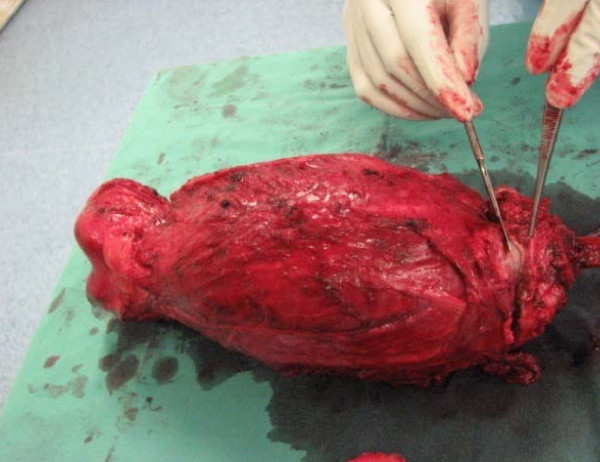
Soft tissue and periosteum is stripped off the primary tumour bone.